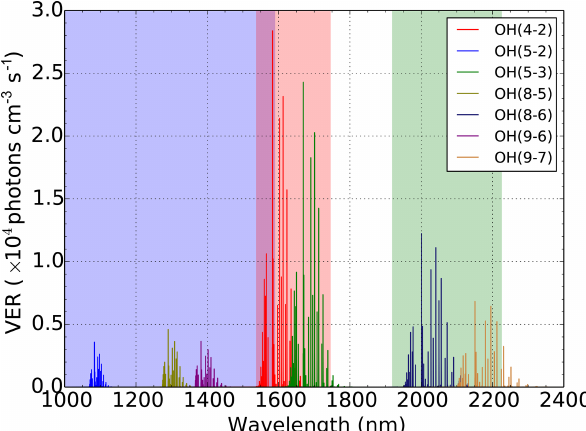
Figure 1. Simulated OH airglow emission bands used in this study in a spectral range between 1000 and 2400nm. Shaded light blue re- gion covers a spectral range observed by SCIAMACHY channel 6; shaded light red and light green regions cover two spectral ranges measured by SABER channel 9 and 8,